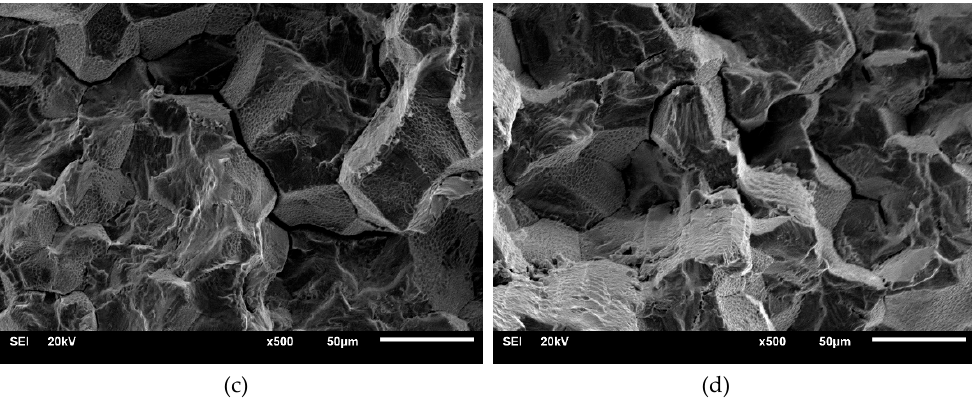
Figure 5. Fracture surface observations of tensile-compression specimen: ( a ) Fracture surface observation; ( b ) Fatigue crack initiation zone; ( c ) Fatigue crack growth zone; ( d ) Final fracture zone.